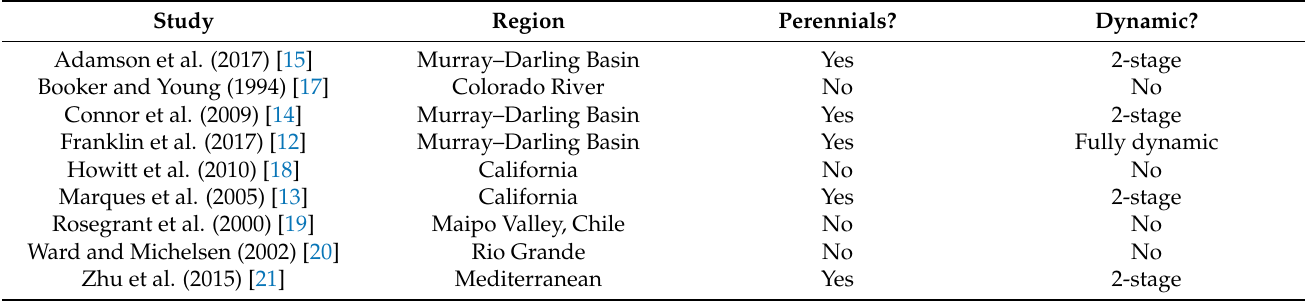
Table 1. Sample of agricultural programming models of arid and semi-arid